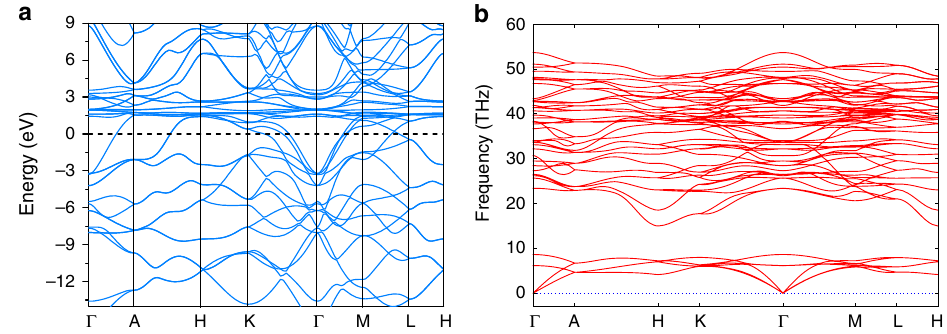
Fig. 7 Electronic band structure and phonon dispersion curves for P6 3 /mmc -CeH 9 at 150 GPa. a Electronic band structure for P6 3 /mmc -CeH 9 at 150 GPa. Dotted line indicates Fermi level. b Phonon dispersion curves for P6 3 /mmc -CeH 9 at 150 GPa. Absence of imaginary phonons in the dispersion curves shows the dynamical stability of P6 3 /mmc -CeH 9 at 150 GPa. Phonon instability at 120 GPa is shown in Supplementary Fig. 8